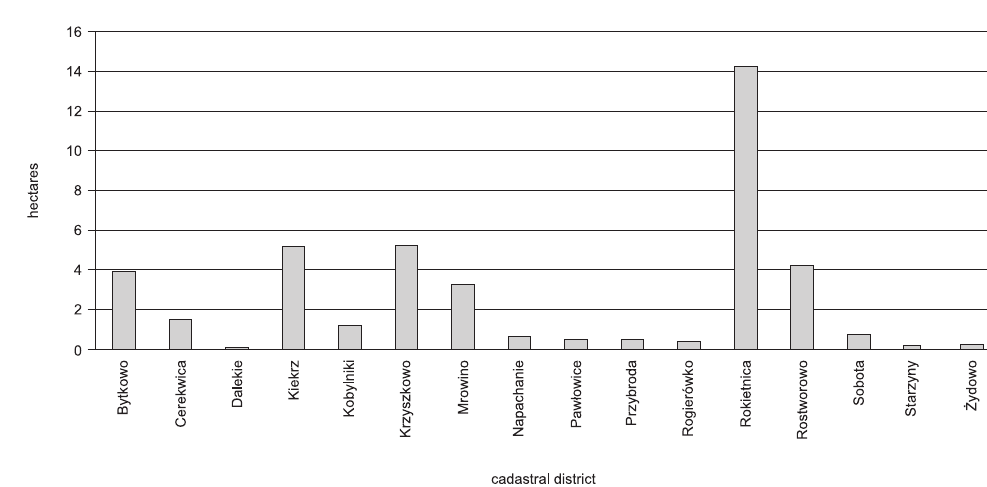
Fig. 5. Area of agricultural land on built-up housing lots in Rokietnica commune, 2014. Source: own compilation on the basis of data from the Poviat Centre of Geodetic and Cartographic Documentation in Poznań.